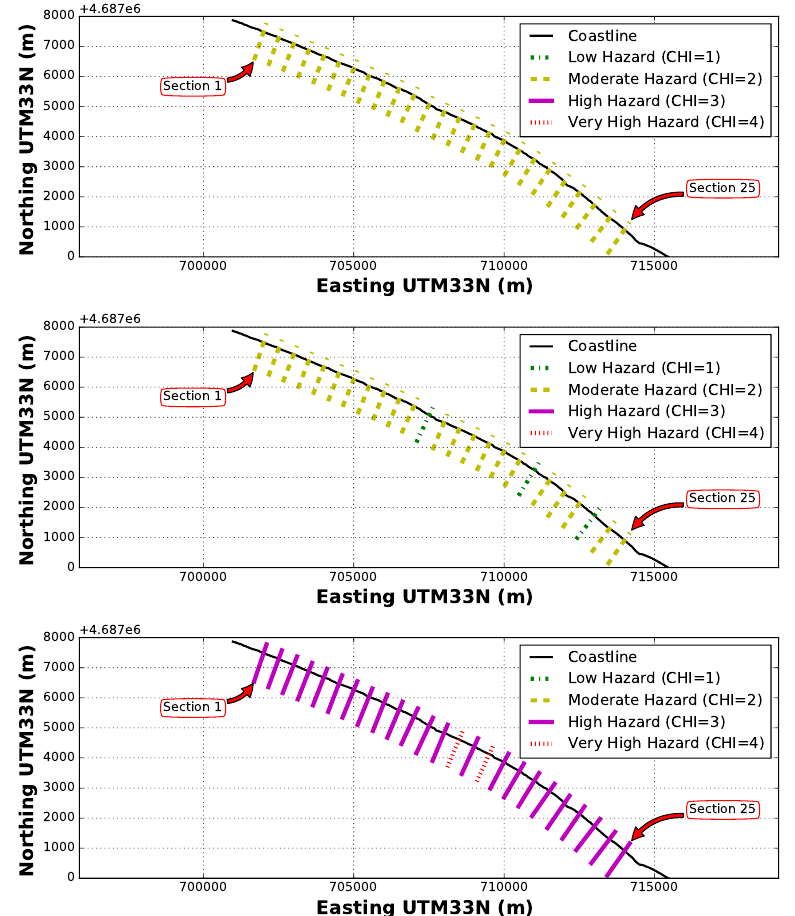
Figure 8. Coastal Hazard Index (CHI) for all the considered cross-sections by using local-scale data ( upper panel ) and national-scale data ( middle panel ). ( Lower panel ) The CHI evaluated by using national-scale data and by amplifying the estimated 2% exceedance wave runup by a factor equal to 1.25. Section numbering, from 1–25, starts from